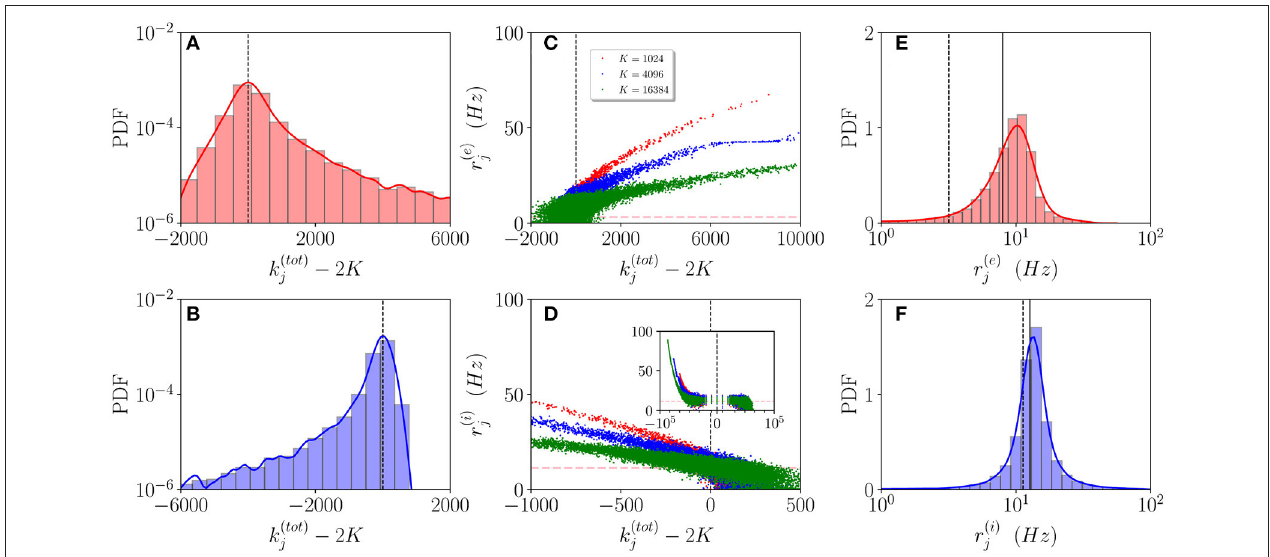
FIGURE 3 | Asynchronous dynamics: Probability distribution functions (PDFs) of the total in-degrees k ( tot ) j for excitatory (A) and inhibitory (B) active neurons for K 16,384. (C,D) Firing rates of the excitatory (inhibitory) neurons r ( e ) j ( r ( i ) j ) vs. their total in-degrees k ( tot ) j = K 16,384 (green). The inset in (D) is an enlargement of the panel displaying the firing rates over the entire scale k ( tot ) j = represent the balanced state solution ( R ( e ) 0 , R ( i ) 0 ). (E,F) PDF of the excitatory (inhibitory) firing rates r ( e ) j ( r ( i ) j ) for K R ( x ) ( R ( x ) 0 ) with x e , i . The red (blue) solid line refers to a log-normal fit to the excitatory (inhibitory) PDF with mean 8.8 Hz (17.5 Hz) and SD of 3.8 Hz (2.3 Hz). The = parameters are the same as in Figure 1 , the firing rates have been estimated by simulating the networks for a total time T s transient T t 40 =